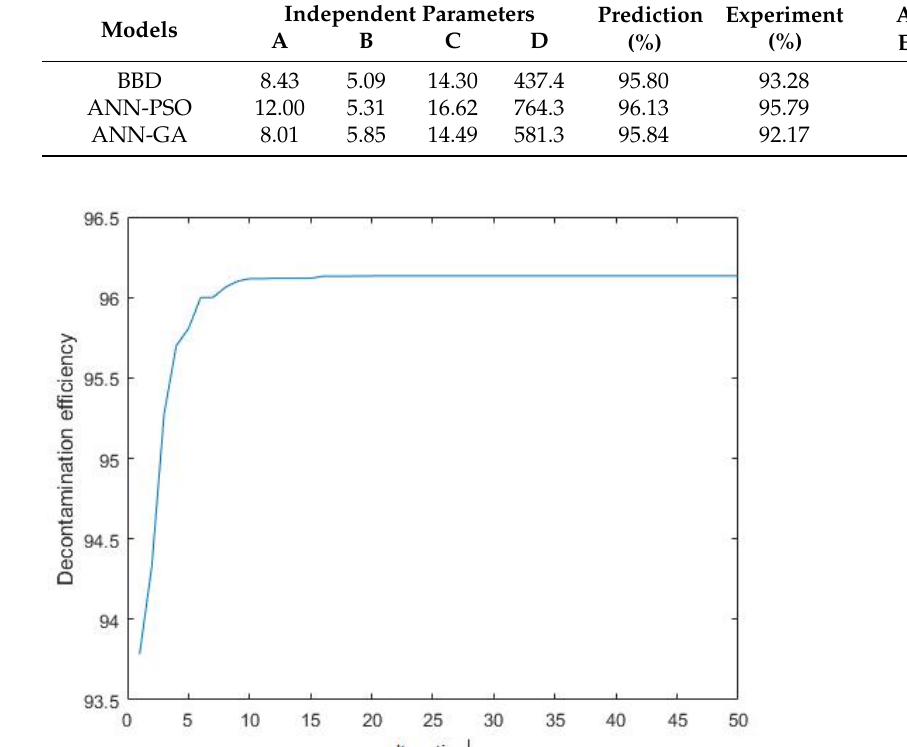
Figure 24. Comparison of the predicted value of the radial basis function and the predicted value of BP with the experimental value.